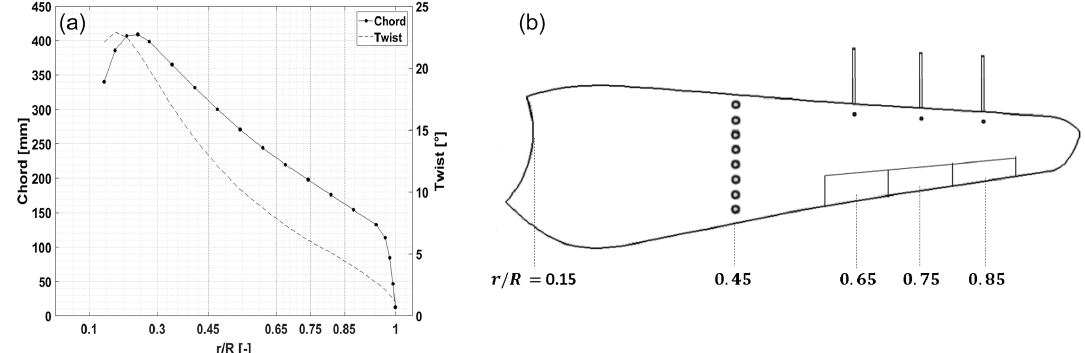
Figure 4. Twist and chord distribution along span (a) . The rotor blade with three-hole probes and pressure taps over span position (b) .